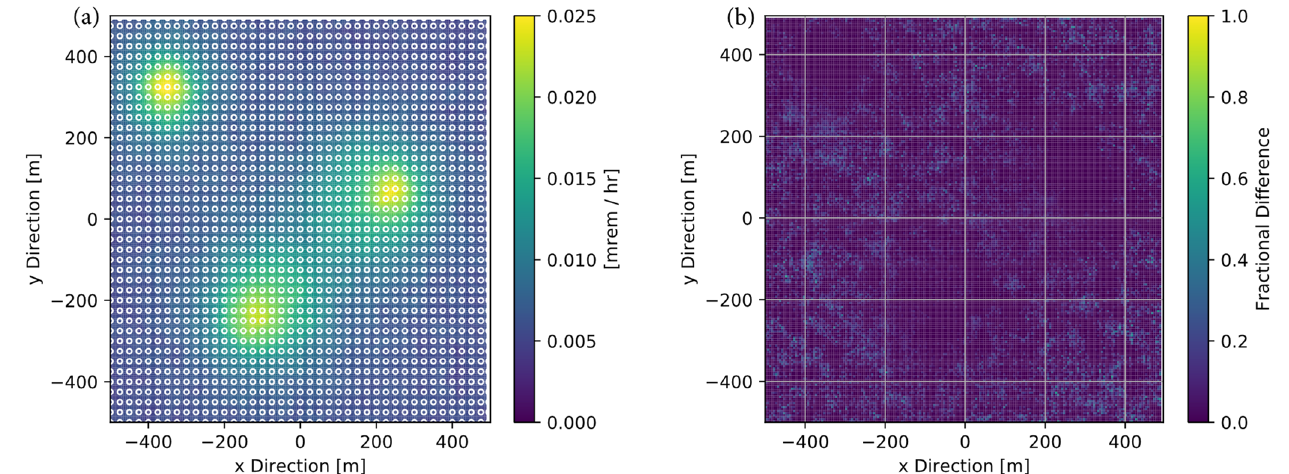
Figure 8. ( a ) Uniform measurement locations with measurements taken every 25 m and linearly interpolated between observation points, and ( b ) the grid-by-grid fractional difference to the true distribution shown in Figure 1. The white markers represent locations where a measurement has been taken.